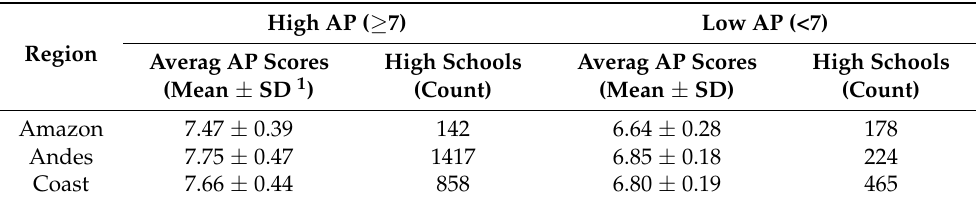
Table 2. Statistical summaries of the average academic performance (AP) scores of students according to their high school, the AP classification, and the regions occurring in our study area.